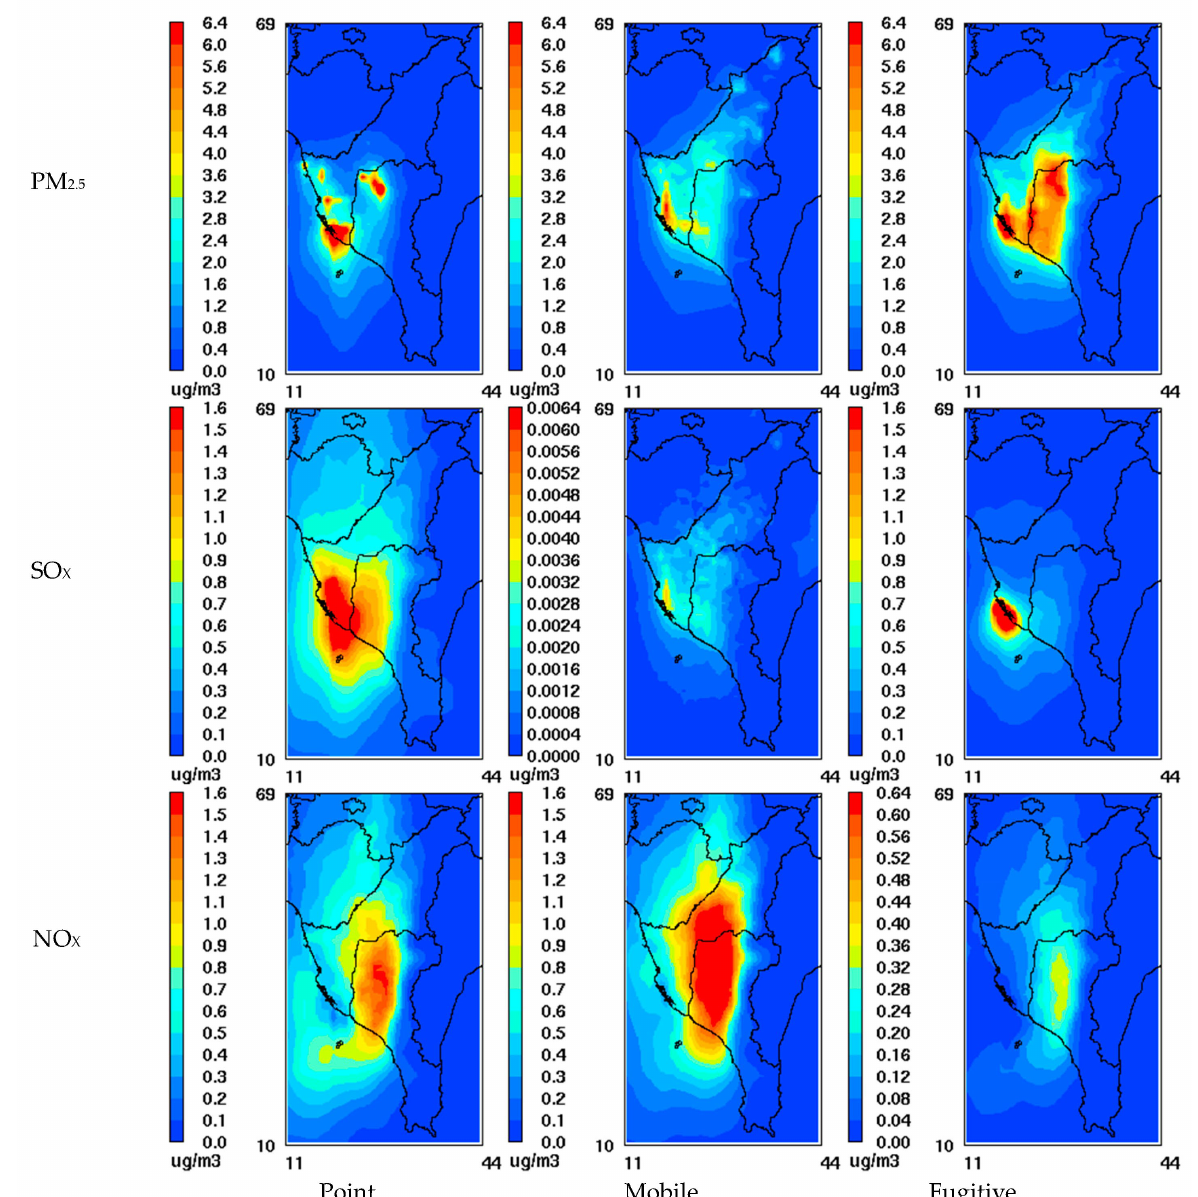
Figure 3. Spatial distribution of the influence of various pollutant emissions from point, mobile, and fugitive sources in KPAB on PM 2.5 concentrations ( µ g/m 3 ). Table 1. Total emissions of pollutants from point, mobile, and fugitive sources in KPAB (10 3 ton/year).